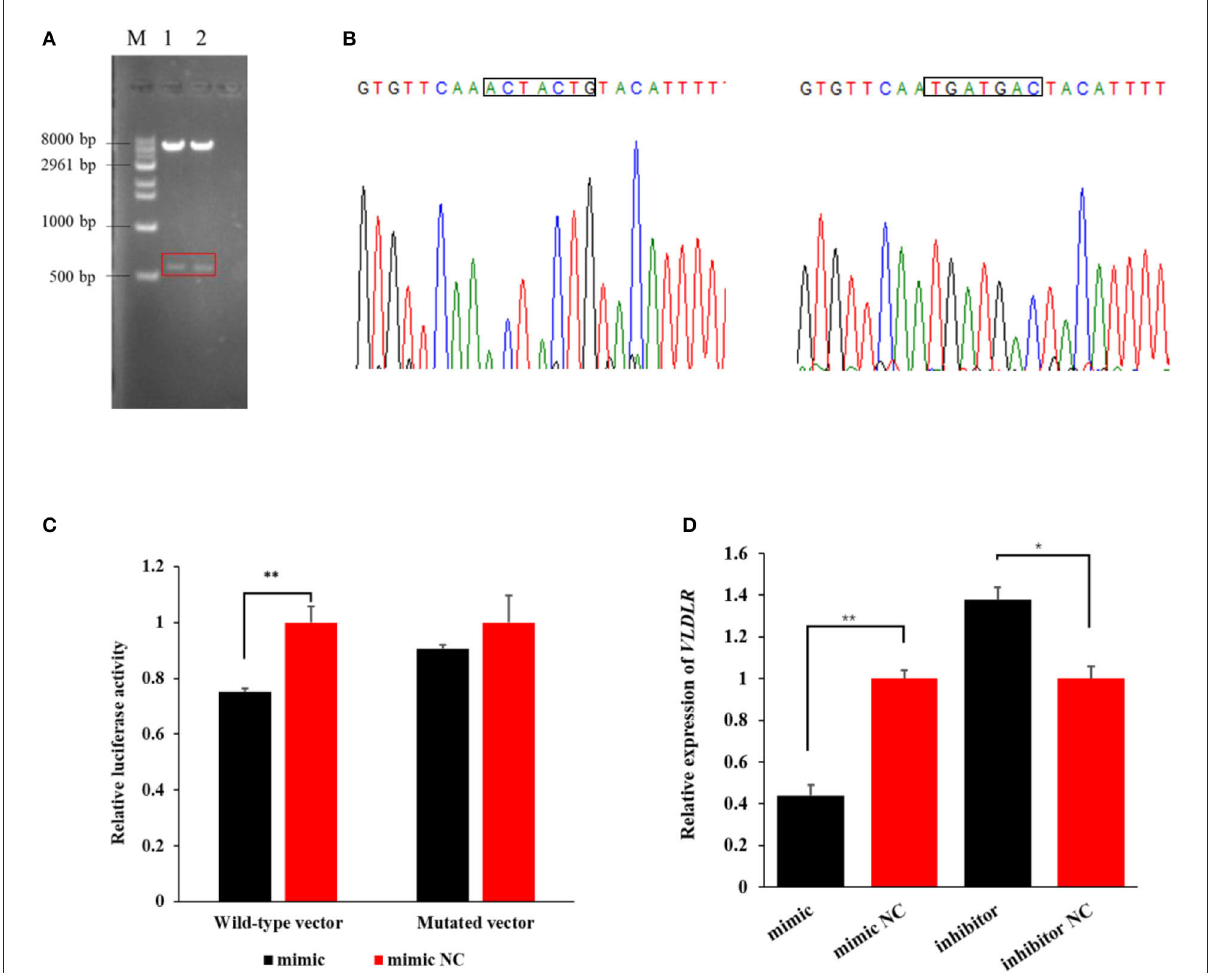
FIGURE3 The target relationship verification of miR-199a-3p with VLDLR using a dual-luciferase reporter assay. (A) Dual luciferase reporter vectors after restriction endonucleases digestion were visualized using agarose gel electrophoresis. M: marker; 1: wild-type vector; 2: mutant vector. (B) The Sanger sequencing result of sequences of wild-type and mutant vectors. (C) The luciferase activity of VLDLR was detected when the miR-199a-3p mimic or miR-199a-3p mimic NC, and wild-type or mutant dual luciferase reporter vectors were co-transfected into HEK293T cells. (D) Effect of miR-199a-3p mimic and miR-199a-3p inhibitor on the expression level of VLDLR in ovine mammary epithelial cells (OMECs). ** P < 0.01 and * P <